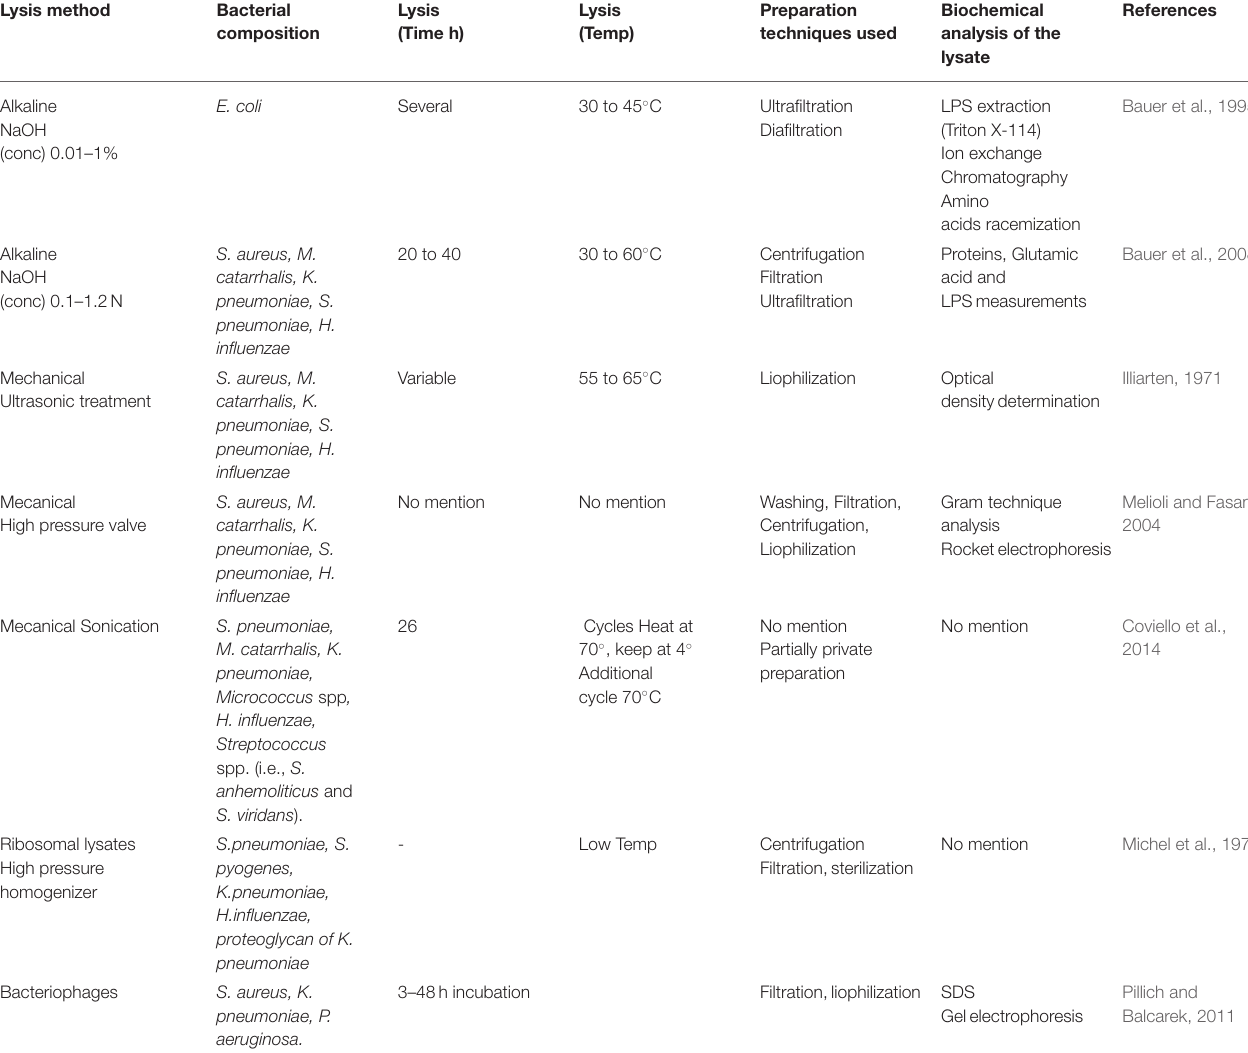
TABLE 2 | Methods of bacterial lysates